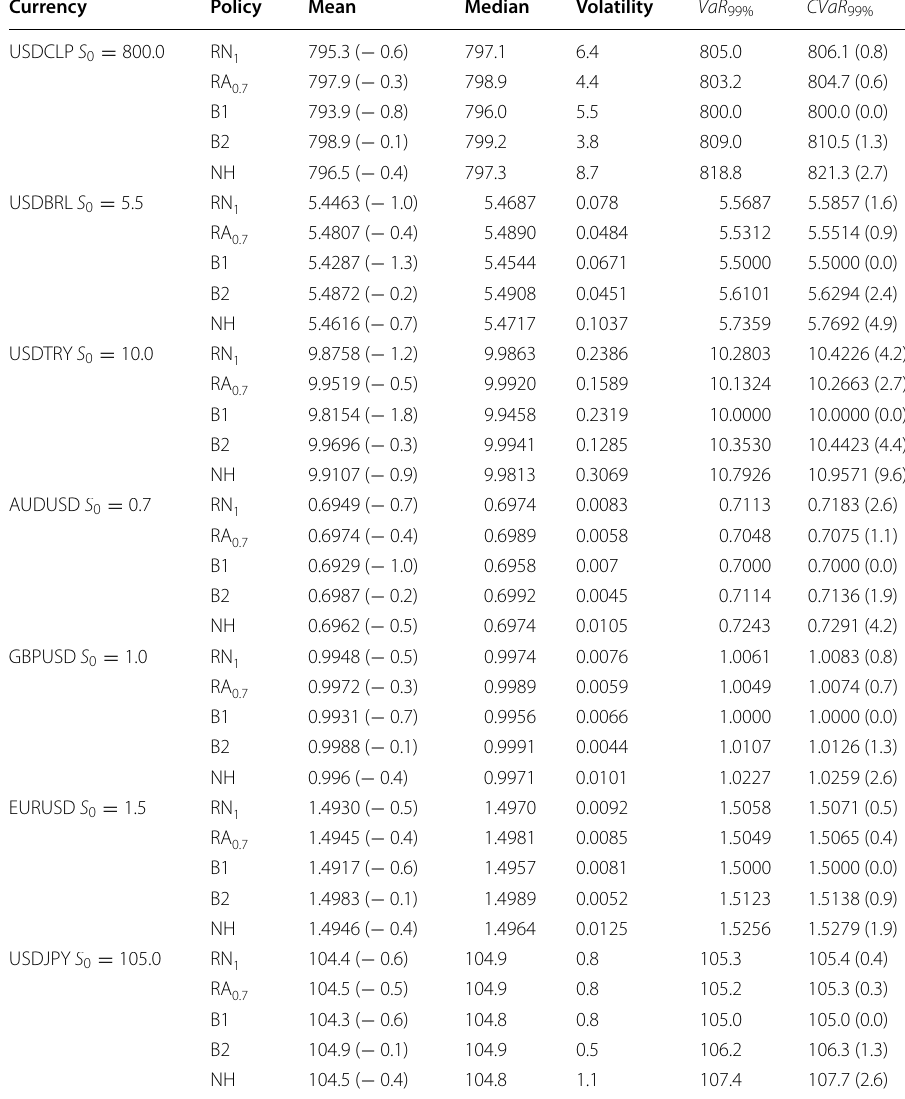
Table 2 Performance of CTP solutions RN and RA versus benchmark policies (B1, B2 and NH), when (π u , π d ) ( 1.25%,3.75% ) =